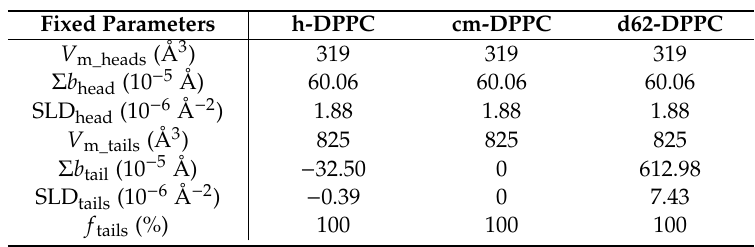
Table 1. Fixed parameters used for data modeling. The molecular volumes of h-DPPC, cm-DPPC, and d62-DPPC are equal; the only di ff erence between the sample parameters is the value of the total scattering length of the tails Σ b tail . One can calculate the scattering length density (SLD) values shown considering b and V m (SLD = Σ b / V m